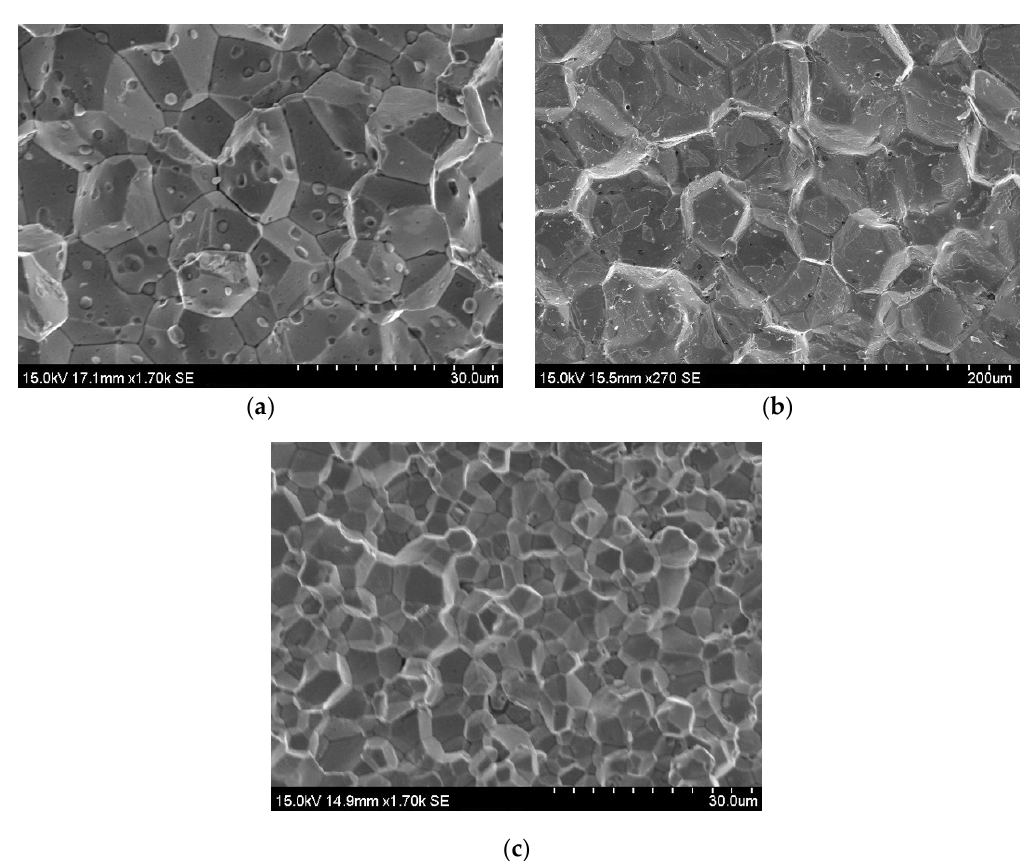
Figure 13. Fracture surfaces of high-oxidized sintered molybdenum: ( a ) at 1750 °C without reduction stage, ( b ) at 1750 °C and with an oxide reduction plateau at 650 °C and ( c ) at 1450 °C with an oxide reduction plateau at 650 °C.